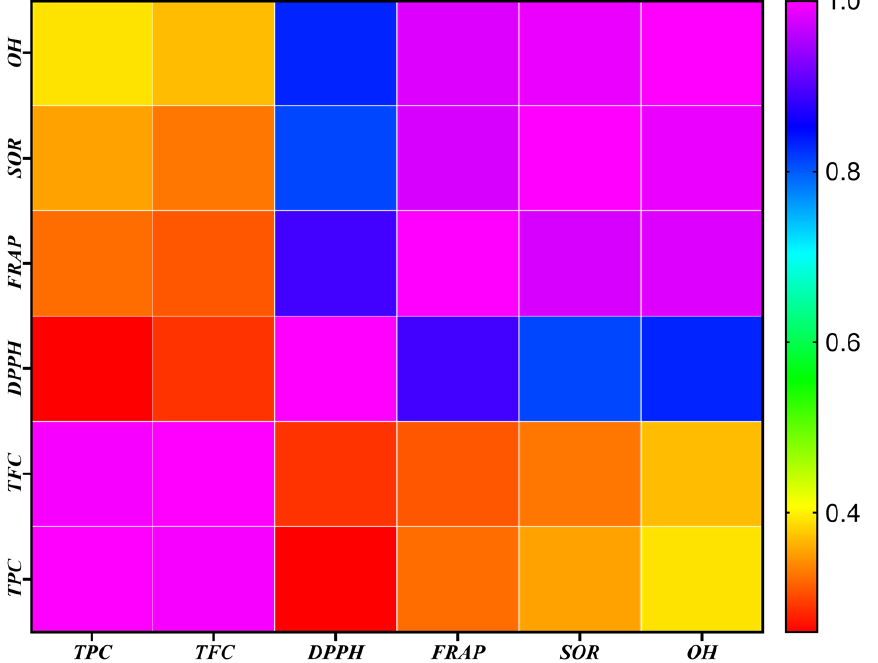
Figure 3. Scatter plots demonstrating Pearson’s pairwise correlation matrix below and along the diagonal in the plot for six variables: DPPH, FRAP, SOR, OH, TPC and TFC. Above the diagonal are the values of the correlation plus the significance level represented as stars (*** p < 0.0000, * p < 0.01).